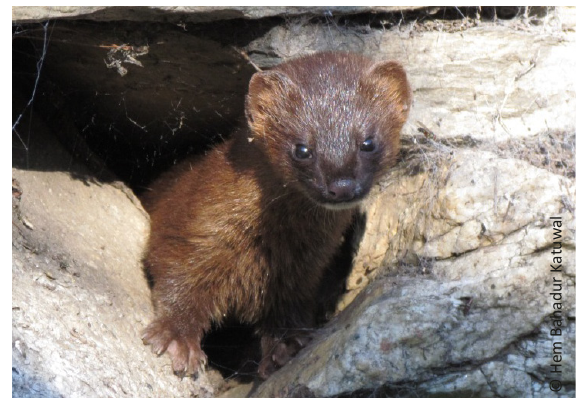
Image 9. Yellow-bellied Weasel Mustela kathiah